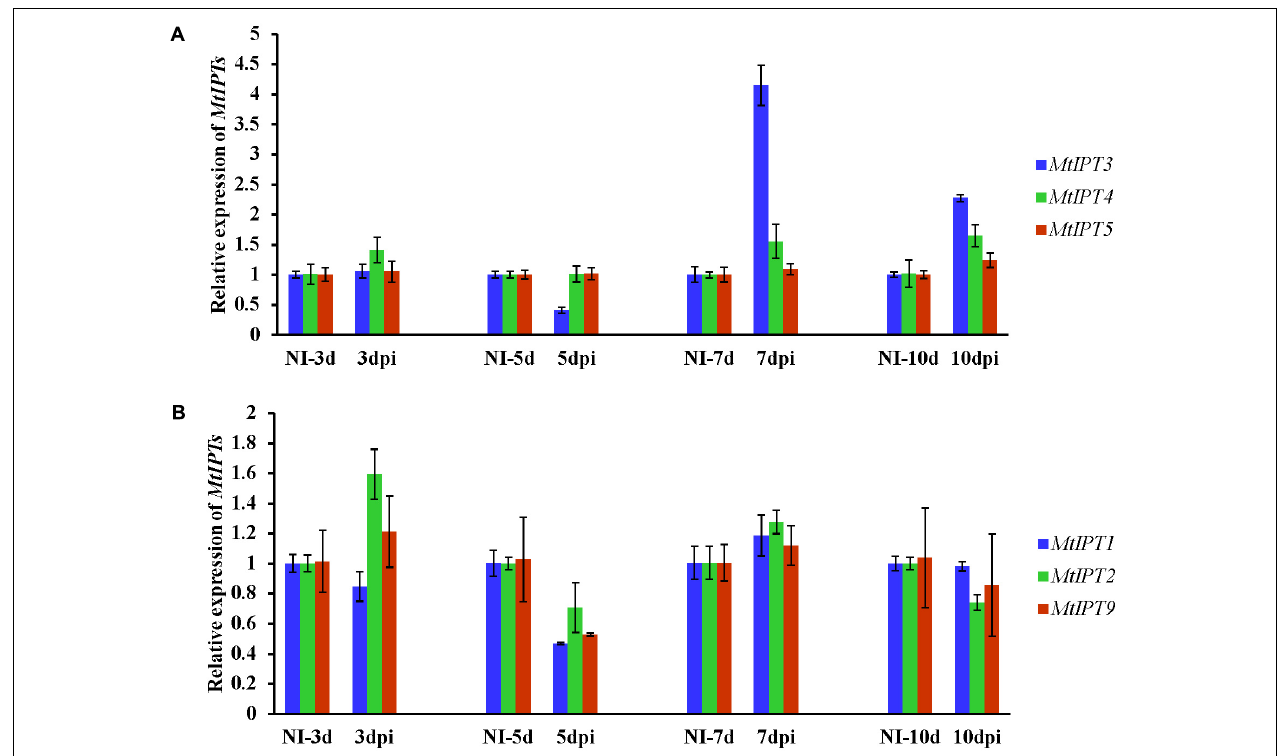
FIGURE 4 | Relative expression of MtIPT3 , MtIPT4 , MtIPT5 (A) , and MtIPT1 , MtIPT2 , MtIPT9 (B) genes in the first leaf at different days post inoculation (3, 5, 7, and 10 dpi) in comparison with non-inoculated plants (NI). Results are mean ± SEM of three technical repeat of one representative biological repeat out of three biological